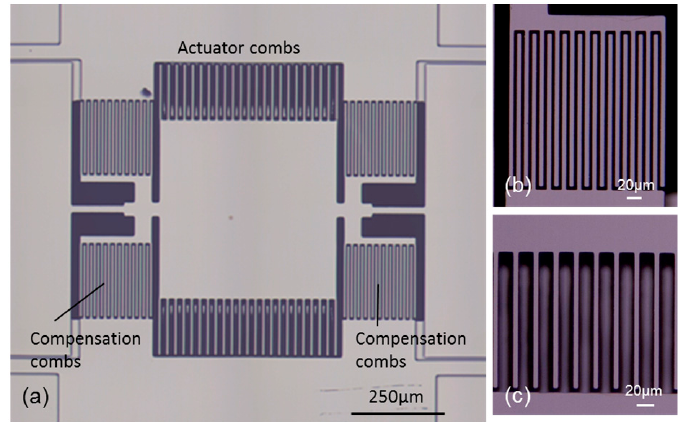
Figure 7. Optical micrograph of the fabricated scanning micro-mirror: ( a ) whole view; ( b ) compensation combs; and ( c ) actuator combs.